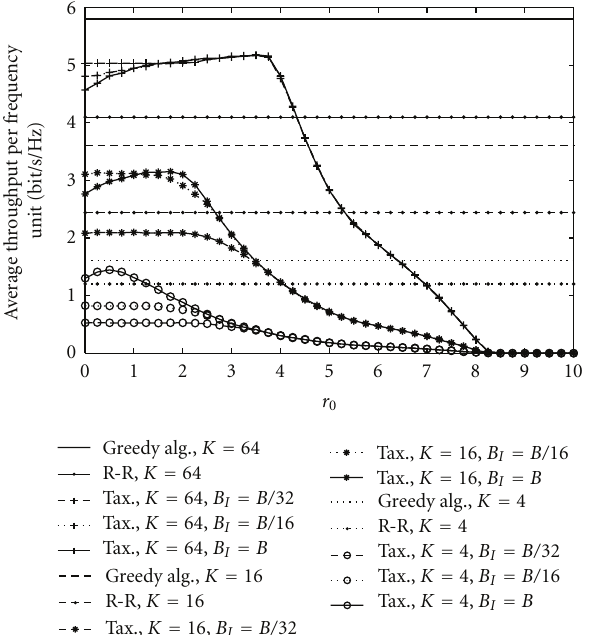
Figure 4: The percentage of served nodes versus the tax rate for SelBM; two-path channel model.